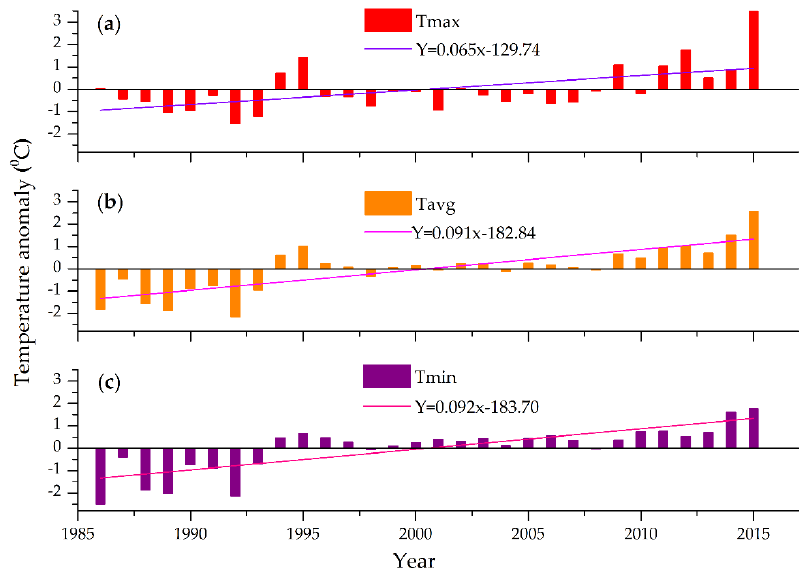
Figure 4. Annual temperature anomaly of the Bilate watershed for the period 1986–2015: for ( a ) the maximum temperature, ( b ) the average temperature, and ( c ) the minimum temperature.